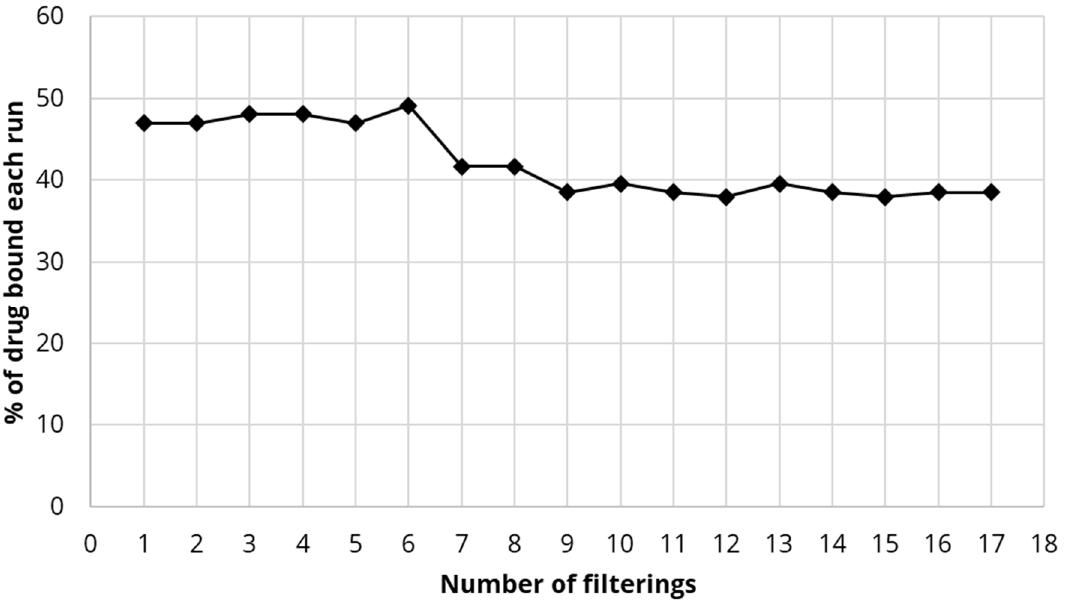
Figure 9. Binding percentage of diclofenac (repeated volumes of 2 L of 2 µ g/mL) for the PDMC-CNC (2 g) integrated commercial filter.